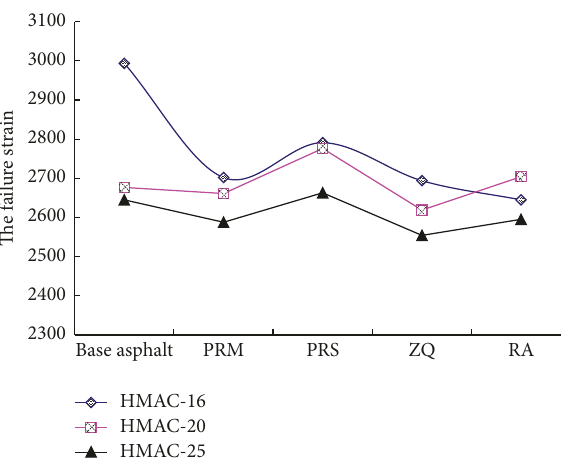
Figure 10: The maximum flexure tensile strain of asphalt mixture.